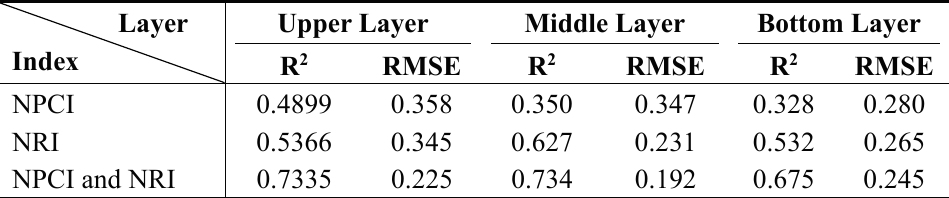
Table 5. Validation results from the three optimal PLSR analysis models for estimating foliage nitrogen density at each layer ( n = 13)